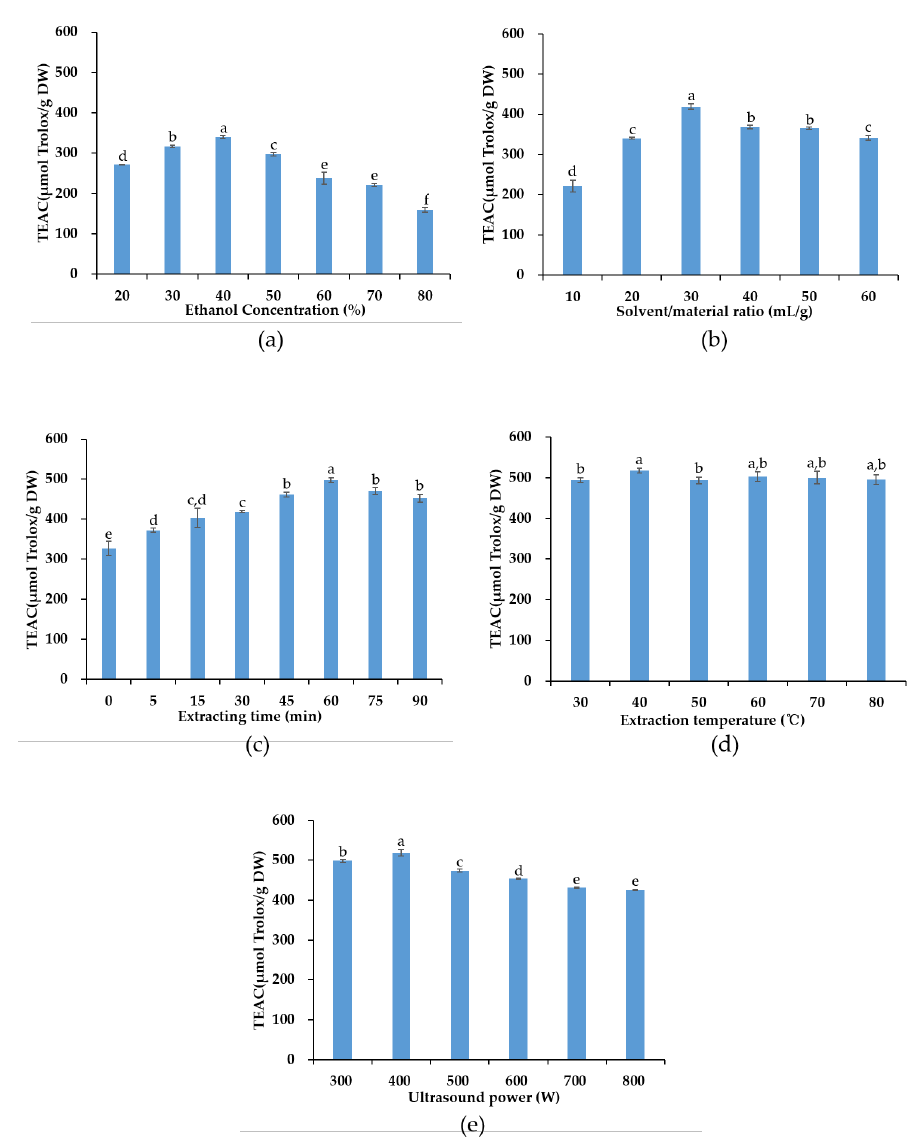
Figure 2. Effects of ethanol concentration ( a ), solvent/material ratio ( b ), extraction time ( c ), extraction temperature ( d ), and ultrasonication power ( e ) on the extraction efficacy. Different lowercase letters indicated statistical significance ( P < 0.05). TEAC, Trolox equivalent antioxidant capacity.